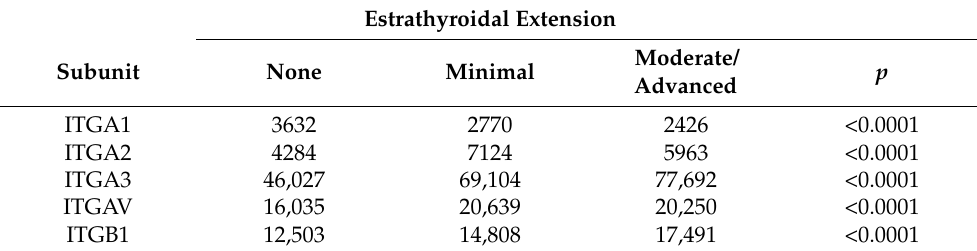
Table 4. Mean gene expression and ANOVA analysis of the correlation with extrathyroidal extension. Only significant data are reported.